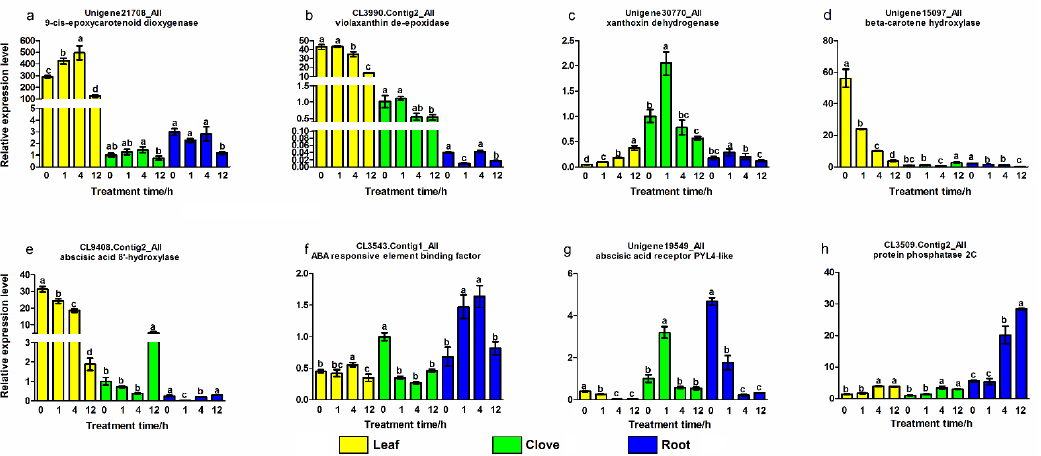
Figure 5. Expression patterns of eight genes involved in abscisic acid metabolism and signaling in garlic samples subjected to drought stress. Genes implicated in abscisic acid metabolism and